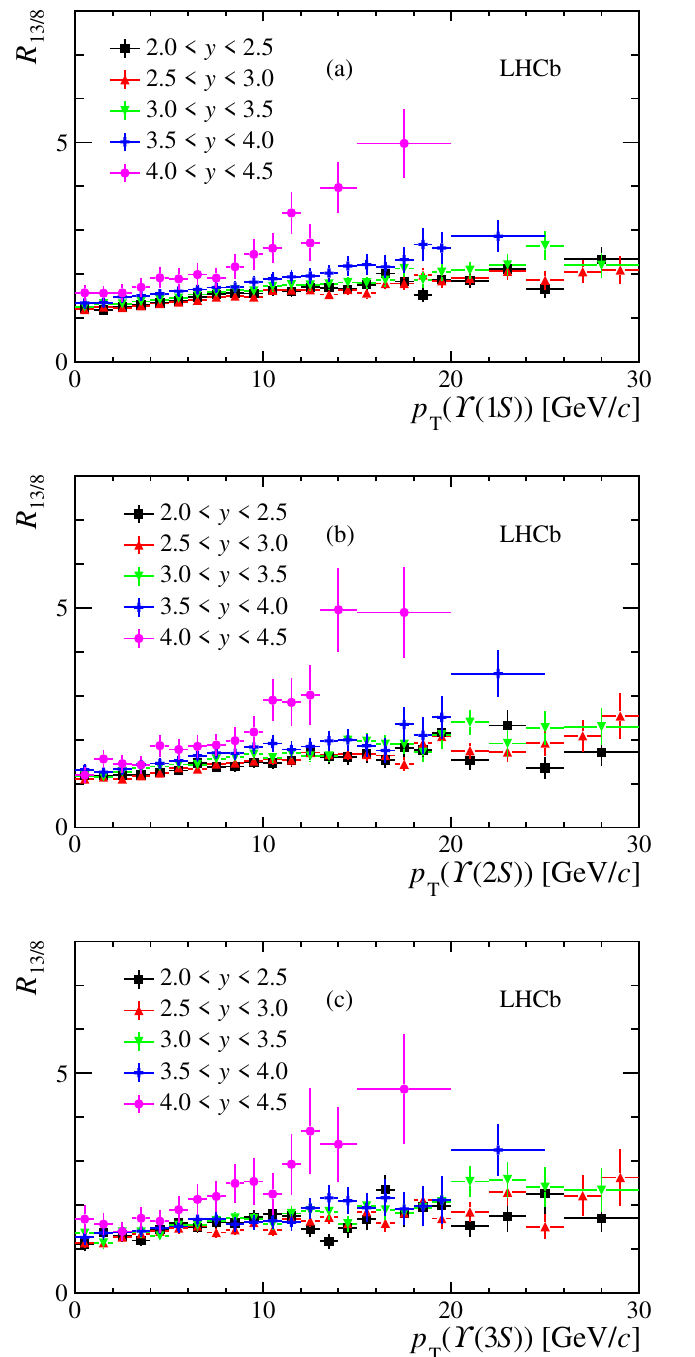
Figure 6 . Ratios of double-di(cid:11)erential cross-sections between 13 TeV and 8 TeV measurements versus p T in intervals of y for the (a) (cid:7) (1 S ), (b) (cid:7) (2 S ) and (c) (cid:7) (3 S ) states. Statistical and systematic uncertainties are added in